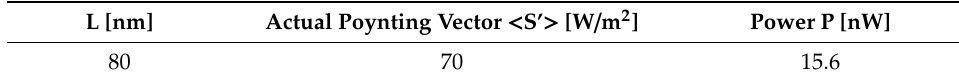
Table 2. Poynting Vector and Optimal Power.